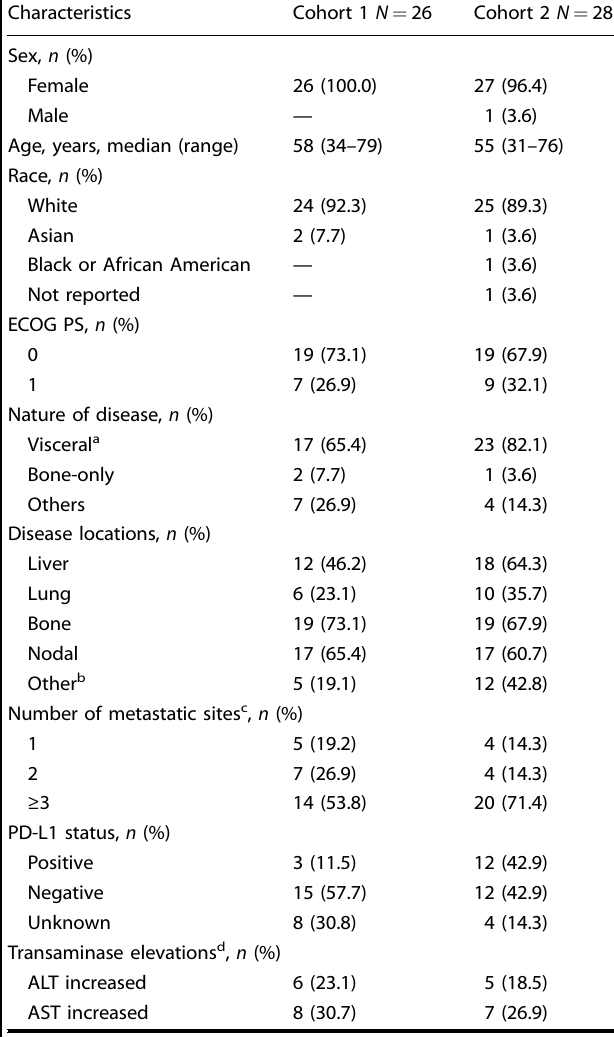
Table 1. Baseline patient demographics and disease